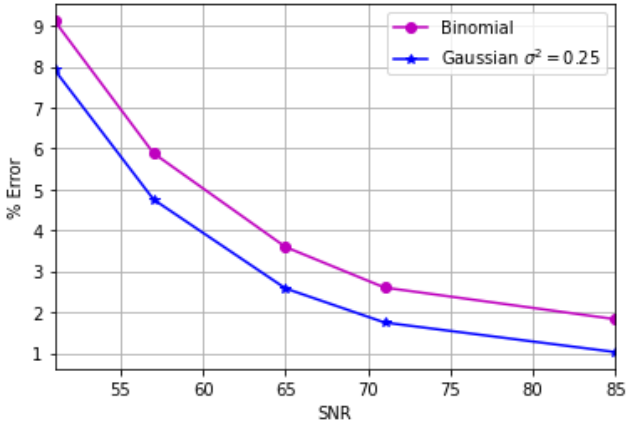
Figure 11. Graph of % error for an image with added Gaussian source noise for a single-lensed microlensing event with µ 0 = 0.1. Binomial and Gaussian measurement matricies, with the given variance, are used for